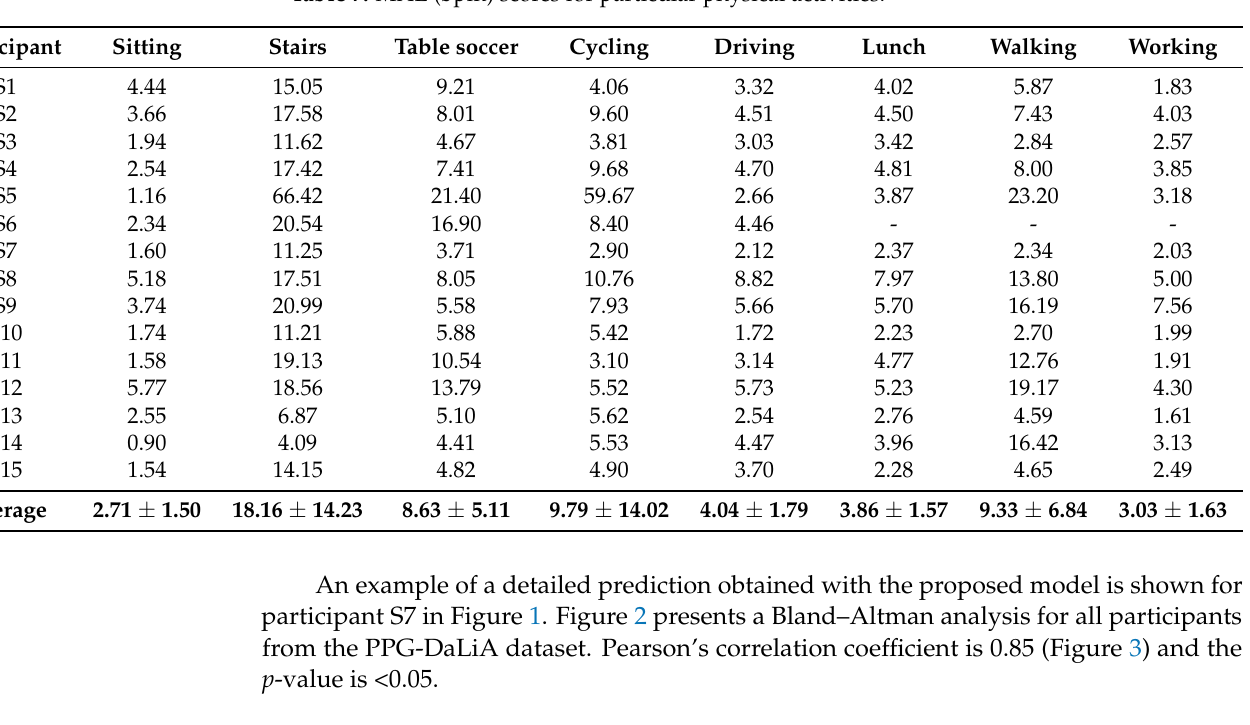
Table 7. MAE (bpm) scores for particular physical activities.